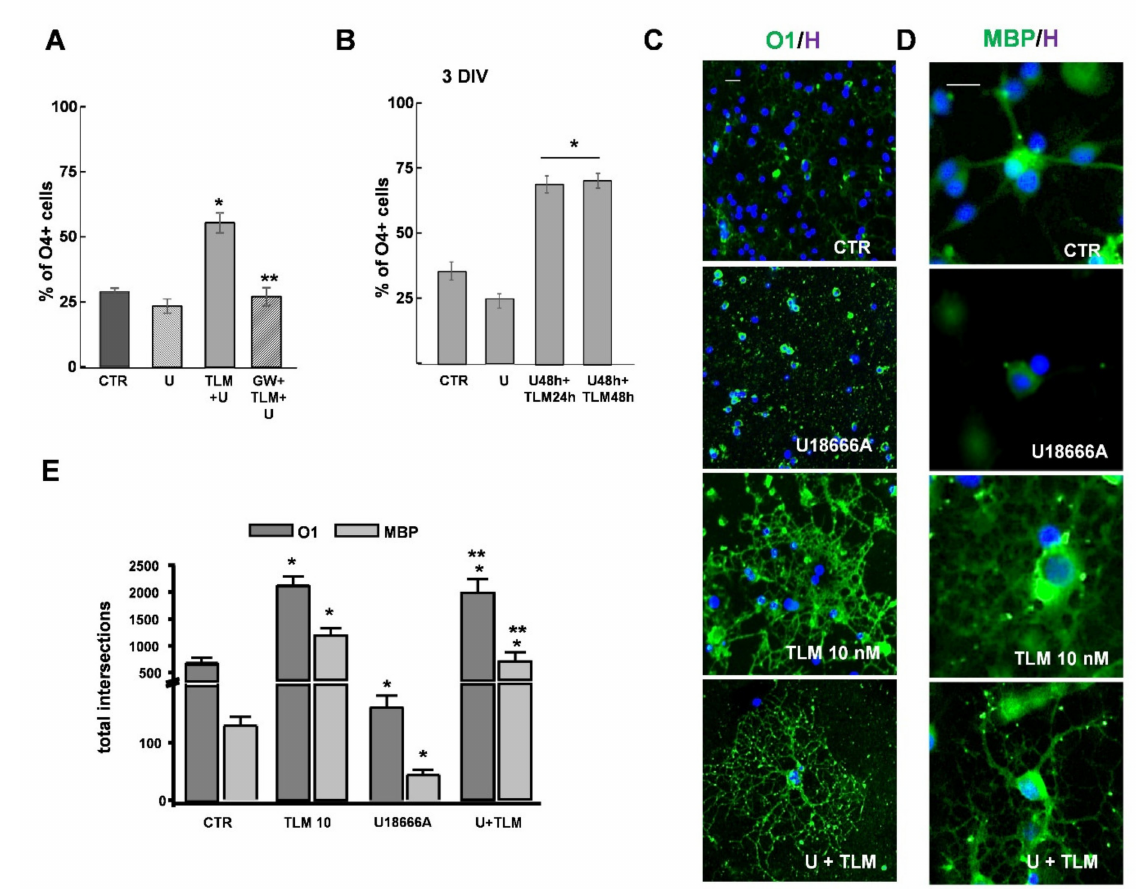
Figure 7. TLM reduces the damage induced by U18666A and promotes OP maturation. OPs were treated for 24 h with TLM 10 nM in the absence or presence of GW9662, and the percentage of O 4 positive cells were evaluated on the total cell number in each condition ( A ). The data are the Means ± SEM of n = 4 (* p < 0.05 vs. U18666A; ** p < 0.0001 vs. TLM+U18666, one-way ANOVA, unpaired two-tailed Student t -test). The effect of TLM added in the last 24 h of U18666A on differentiation is shown (* p < 0.001 unpaired two-tailed Student t -test) ( B ). Data are the percentage of O 4 positive cells evaluated on the total cell number in each condition. Cells after 48 h treatment with U18666A (U) and/or TLM at 10 nM (3DIV) are labelled with O 1 ( C ) or anti-MBP ( D ) antibodies (green) and Hoechst 33258 (blue). The photomicrographs show the different cell morphologies—Scale Bar = 30 µ m. The complexity of a single cell was assessed by Sholl analysis. The bar graph shows the presence of the total intersections for each Sholl profile delineated in the same cell ( E ). Data represent Means ± SEM n = 3 (50–60 cells/condition labelled for O 1 or MBP; * p < 0.001 vs. CTR; ** p < 0.05 vs. U18666A, one-way ANOVA, unpaired two-tailed Student t